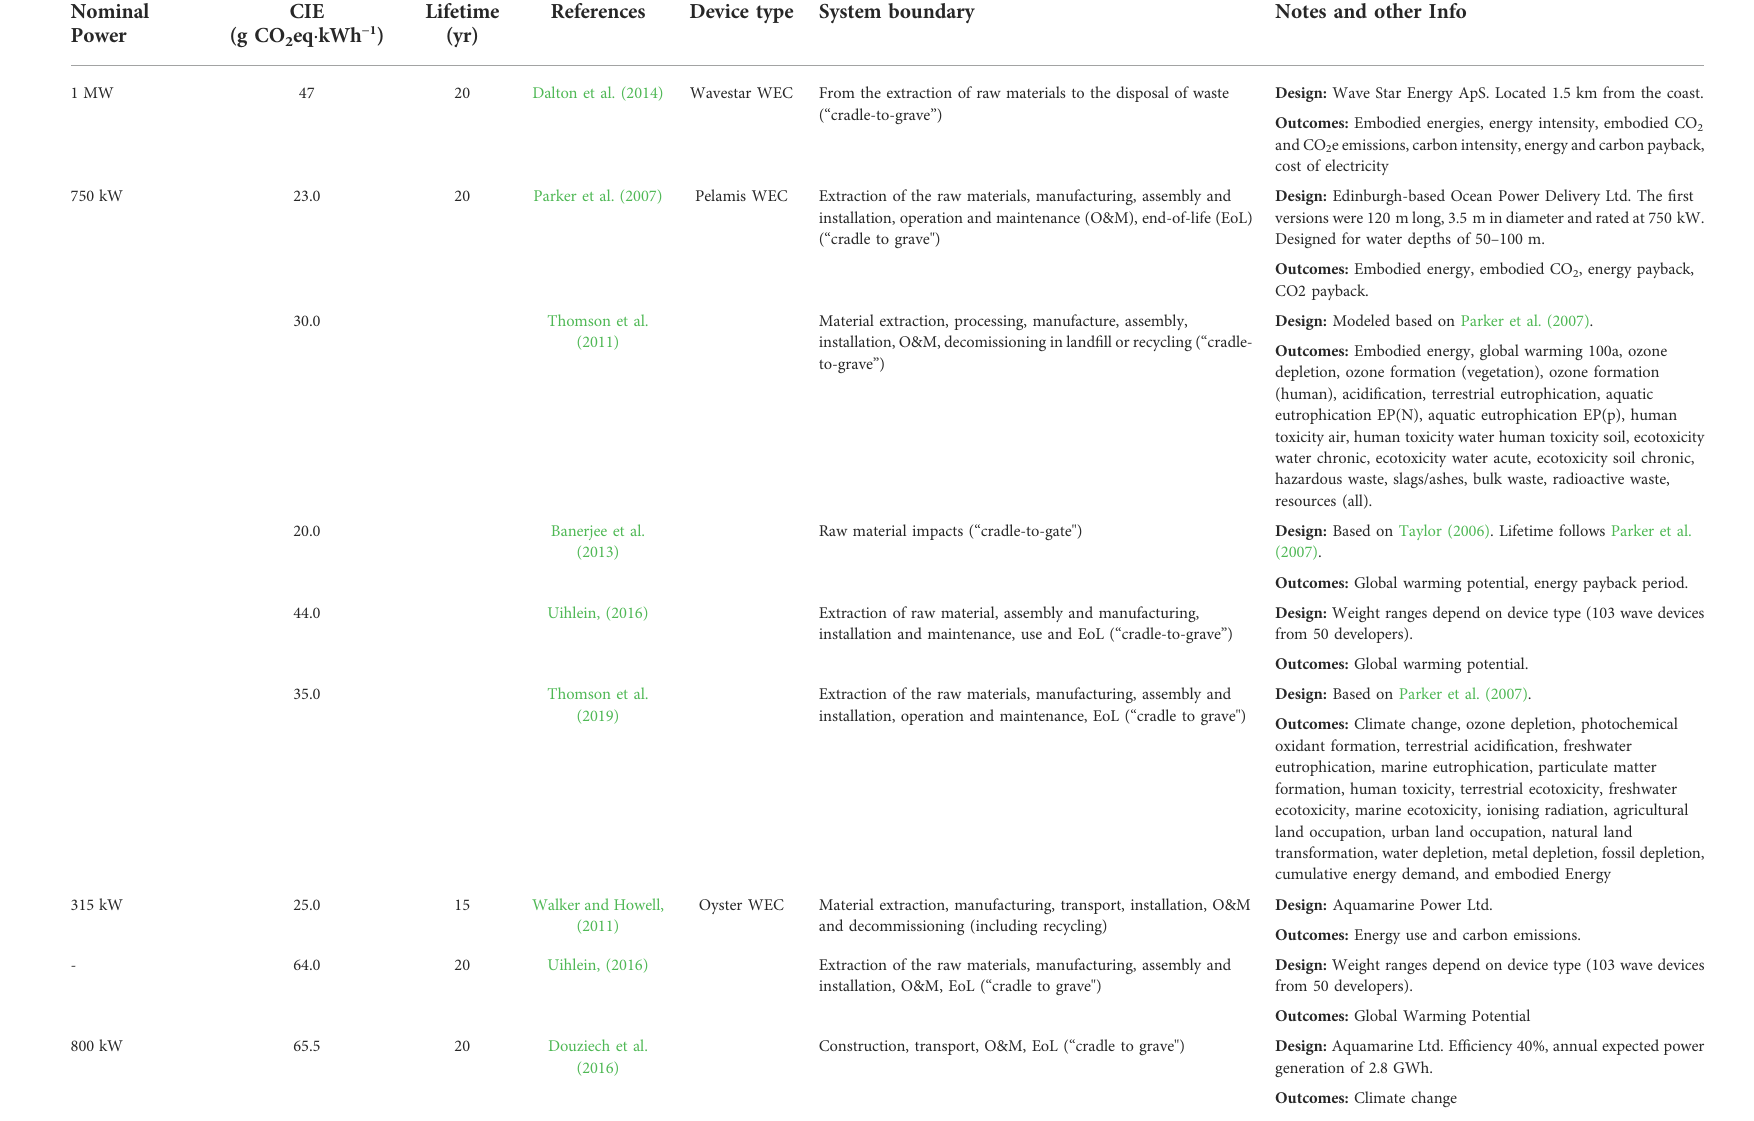
TABLE 1 Literature review of previous LCA studies on WECs and focus on the Carbon Intensity of Electricity (CIE) (g CO 2 eq · kWh − 1 ) evaluation. Nominal